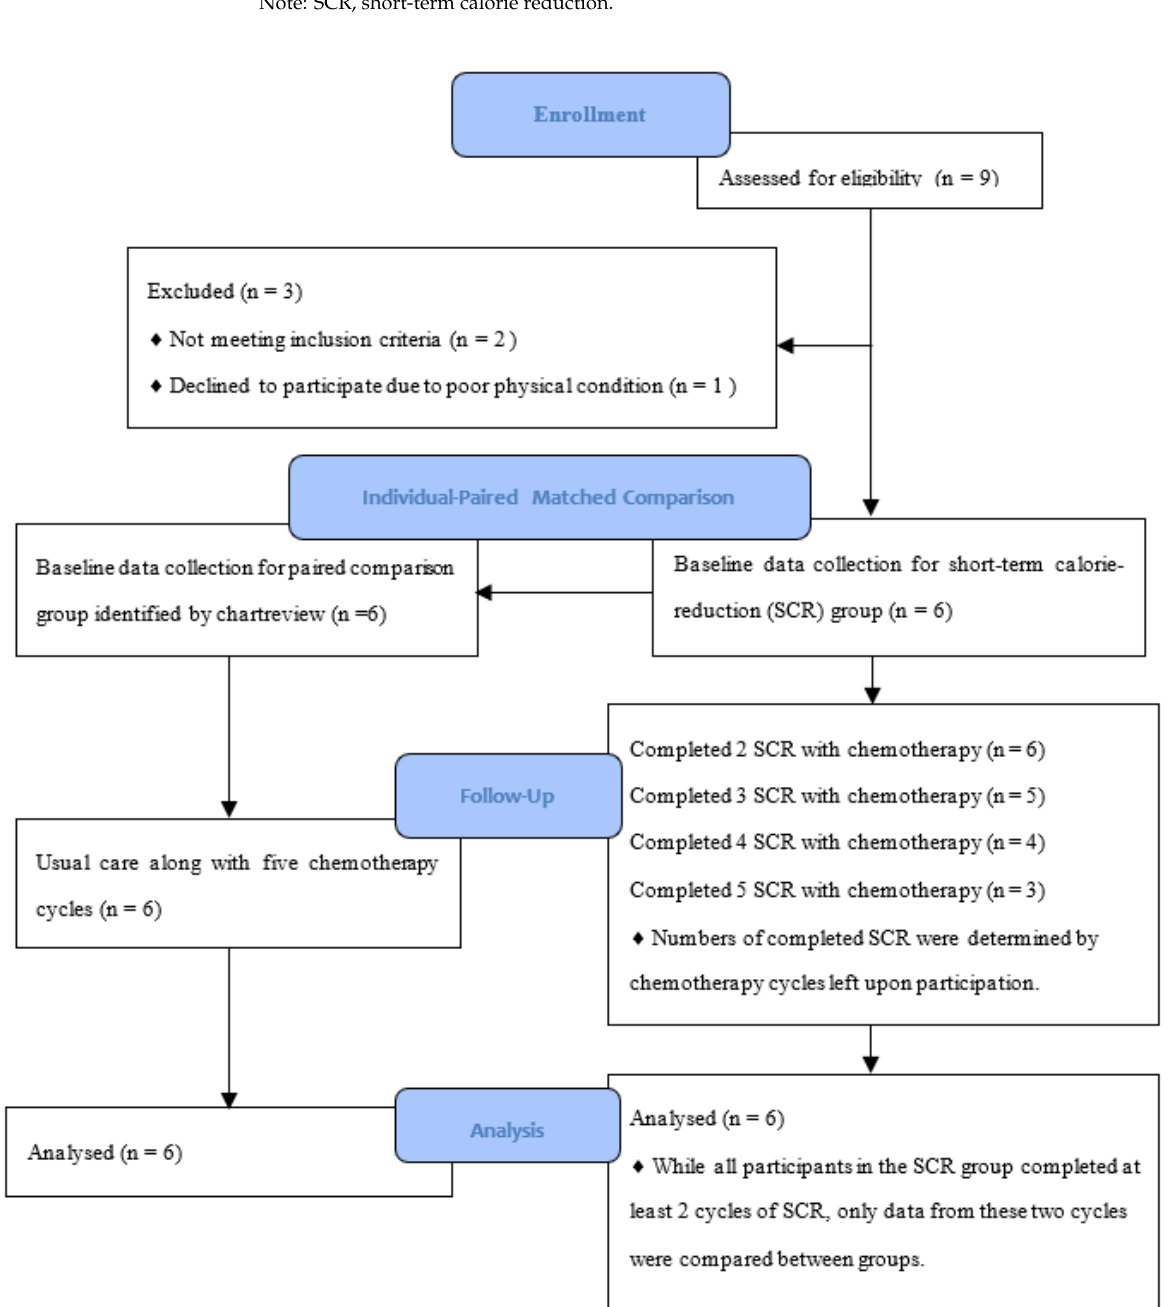
Figure 1. Flow Diagram of Recruitment and Follow-up. SCR, short-term calorie-reduction. Table 2. Outcomes of short-term calorie reduction (SCR) and comparison groups before and after intervention. Outcome Indicators